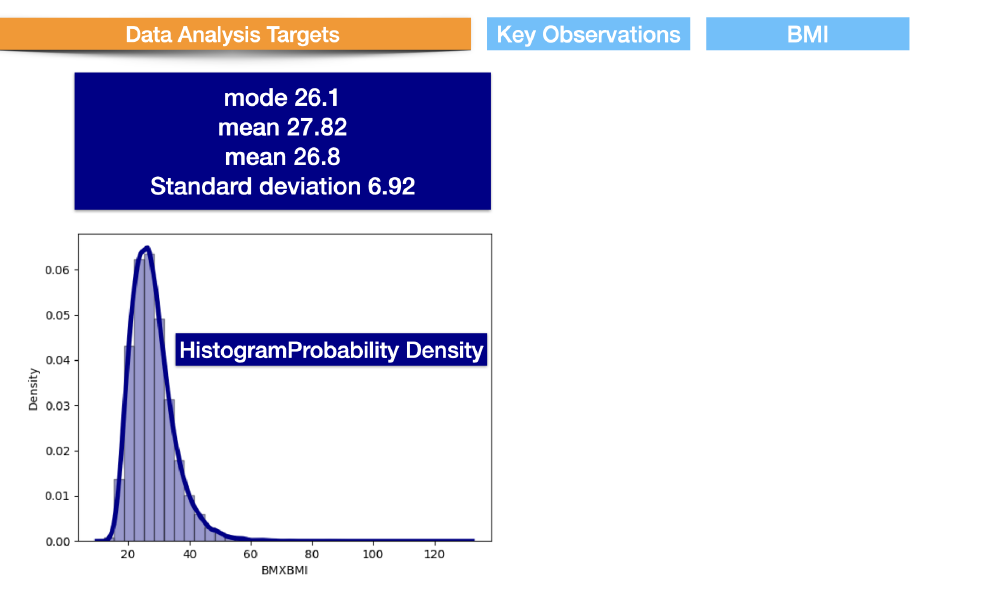
Figure 6. Key observations